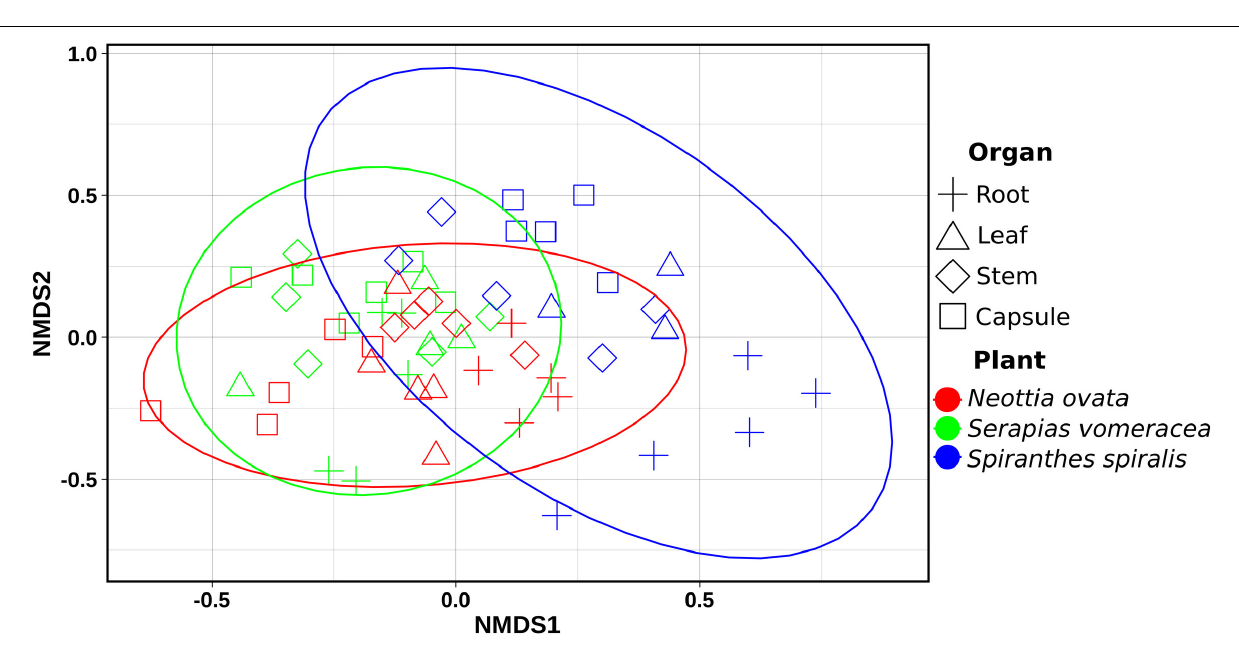
S. vomeracea and S. spiralis (141, 191, and 386, respectively), whereas 195 OTUs were shared between all three species ( Figure 6A ); the latter represent the “species core